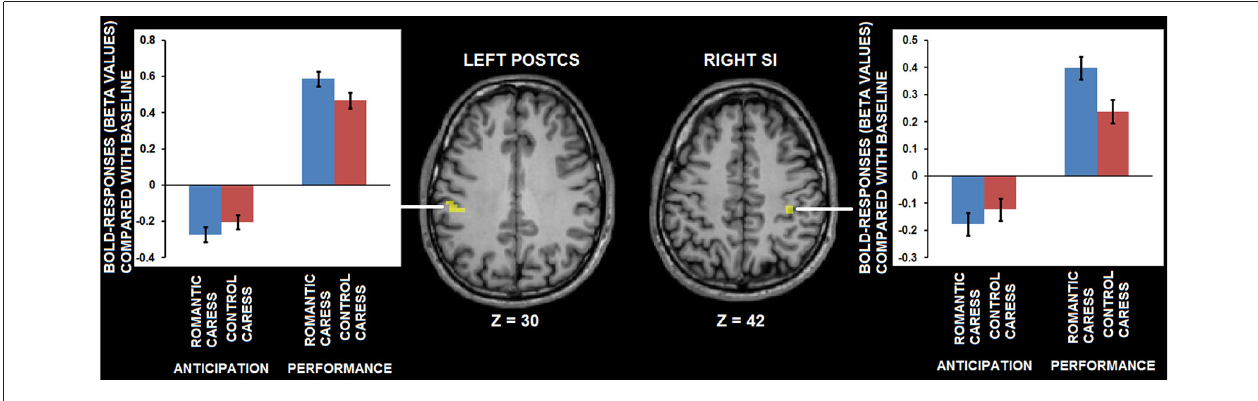
detected by conjunction analysis thresholded at t > 3.61, p < 0.01 corrected. Abbreviations: PostCS: postcentral sulcus; SI: primary somatosensory cortex.